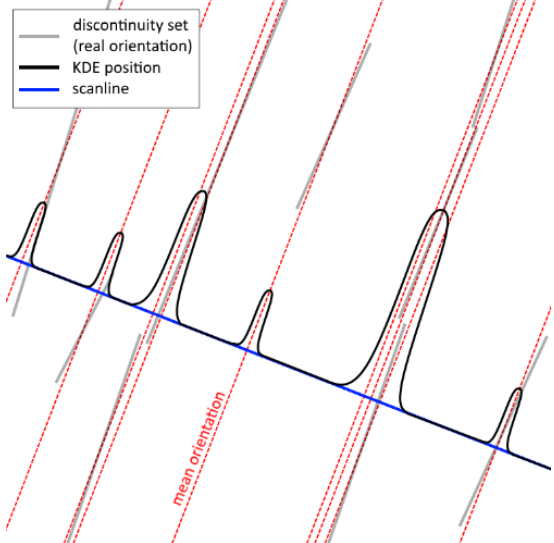
Figure 3. KDE analysis on discontinuities positions along the normal to the average